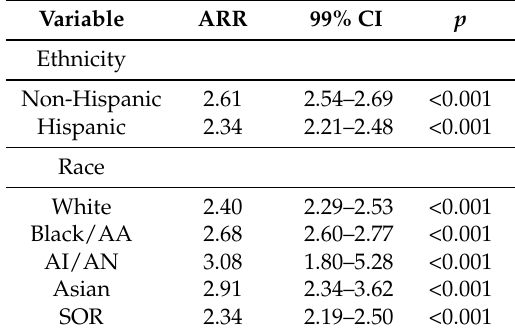
Table 5. Adjusted multi-level risk ratio on the relationship between total cholesterol and BMI by